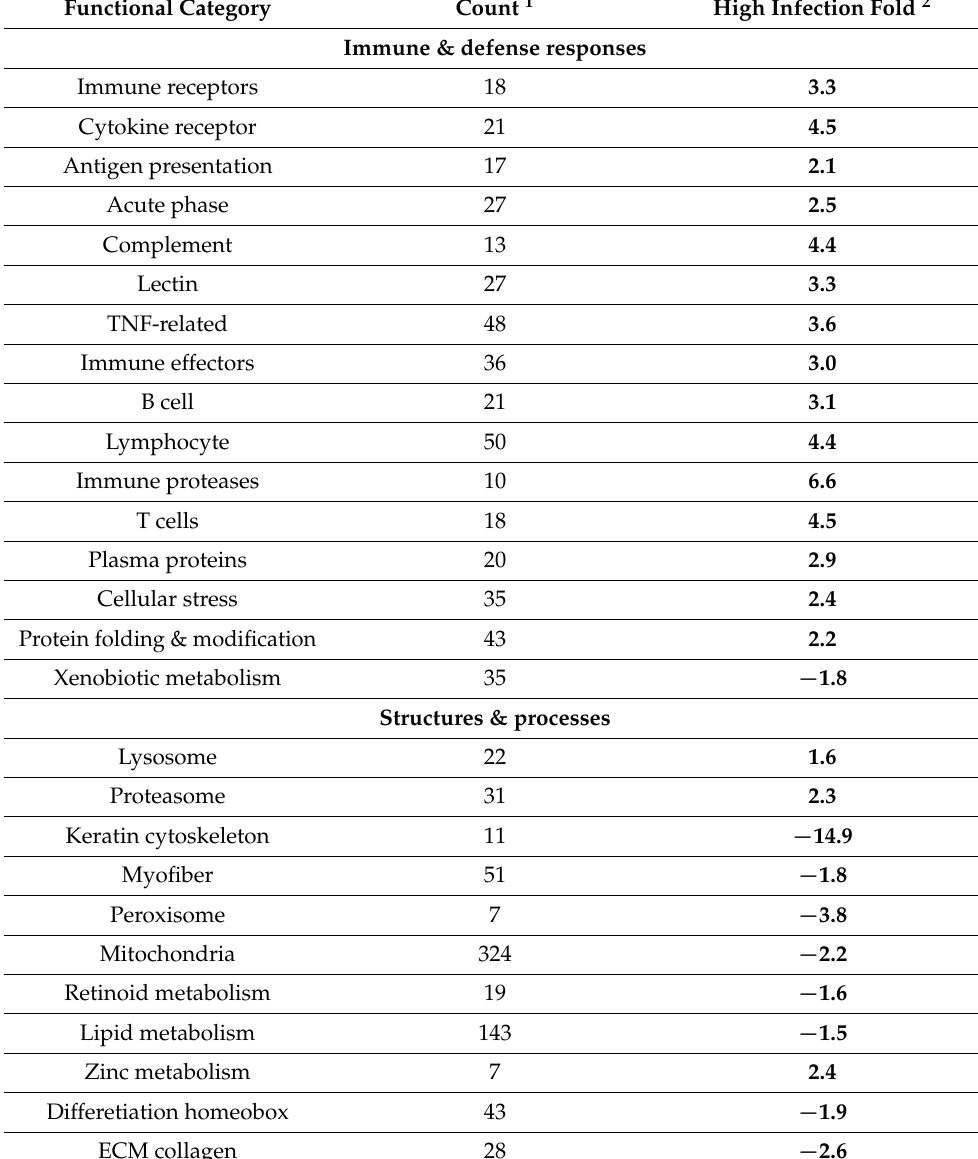
Table 6. Enriched STARS functional groups in